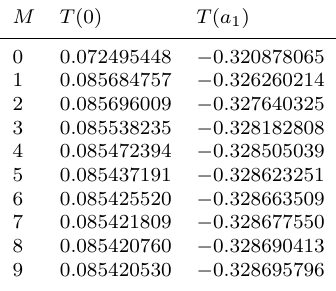
Table 1. Temperature in two points of the model for different numbers of M , while other problem parameters are: θ = 0, λ k = 100 , γ k = 0 . 01, β k = − 0 . 01 and the configuration of the inclusions being defined by (4.1).